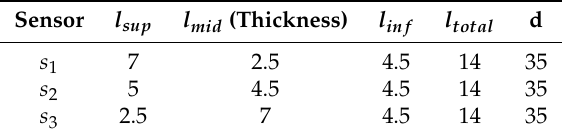
Table 1. The dimensions of the different proposed sensors in